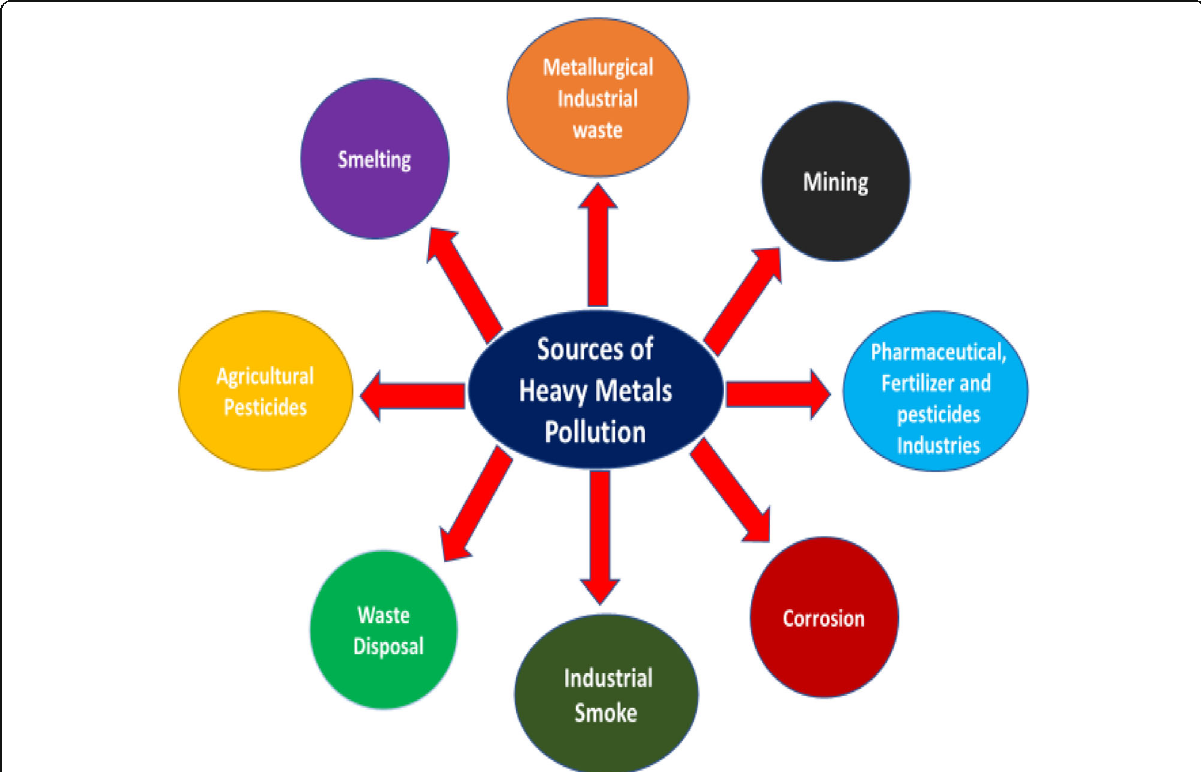
Fig. 2 Sources of heavy metal contamination in the